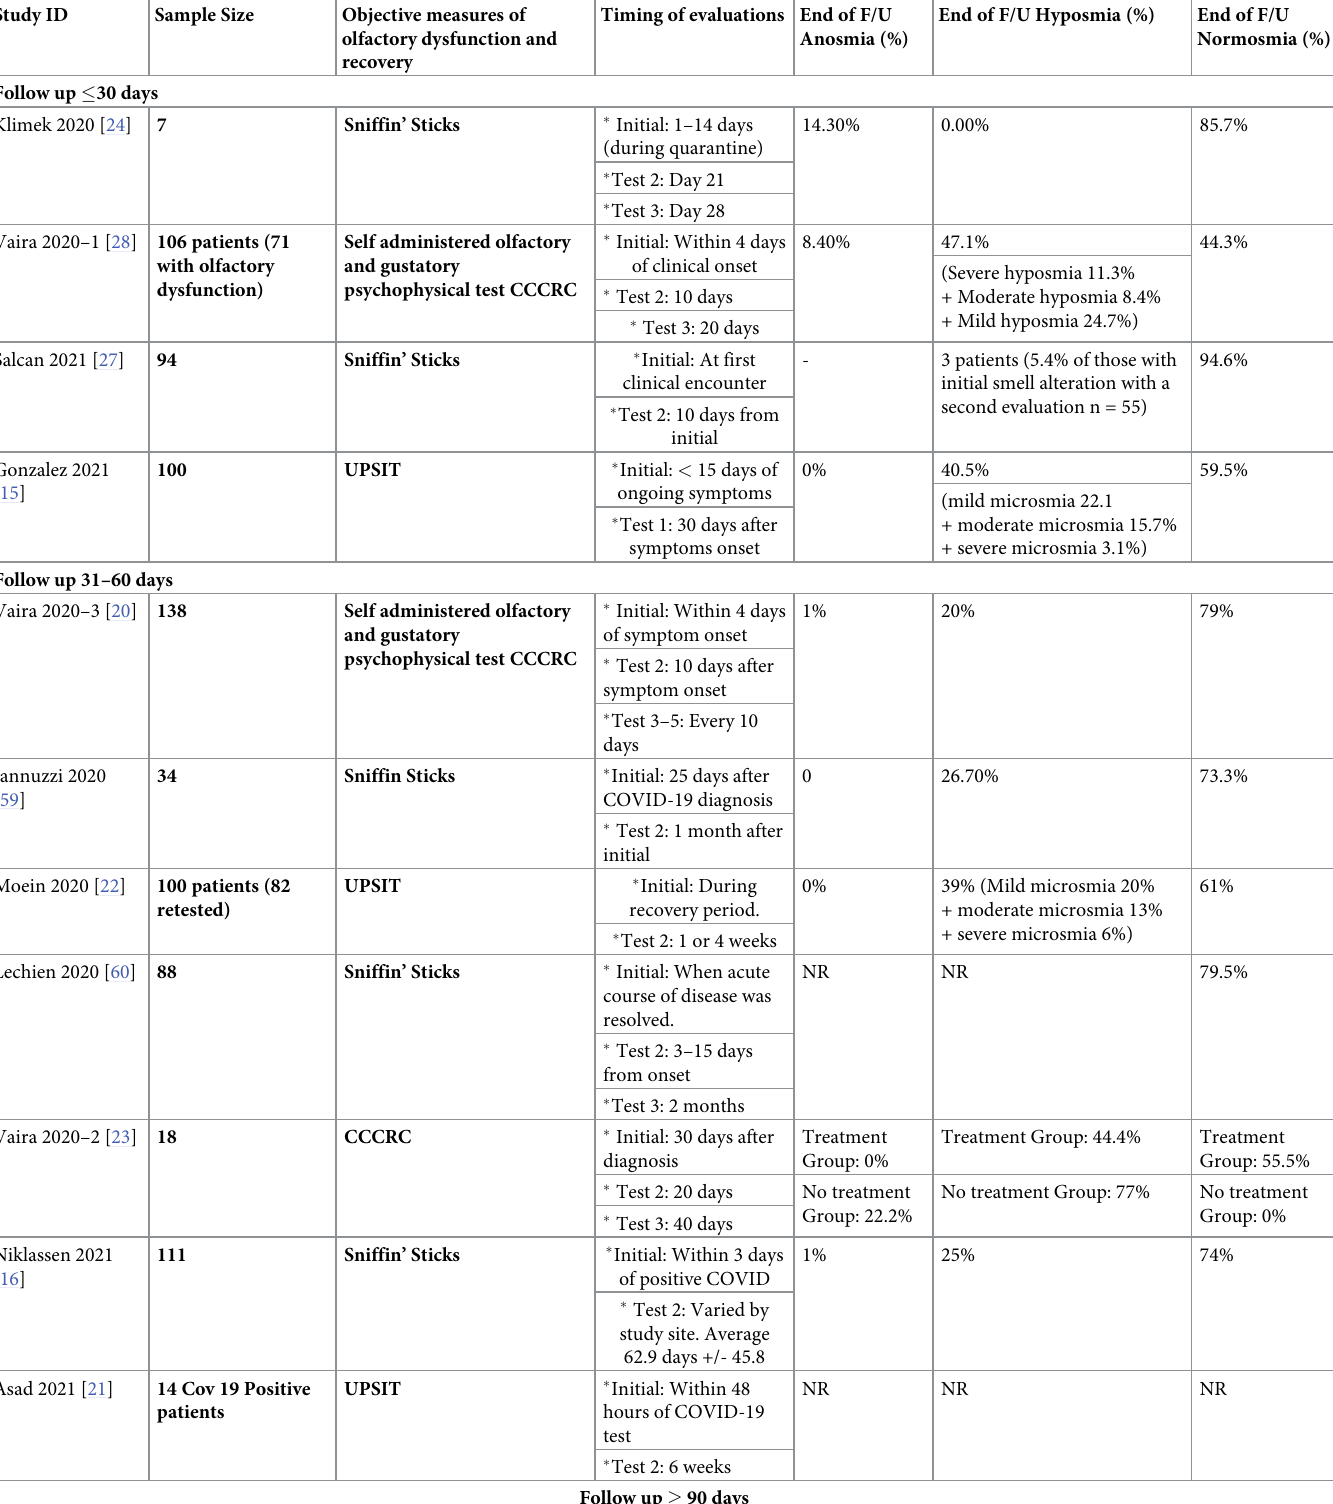
Table 4. Olfactory recovery at the end of follow up in studies that used objective olfactory